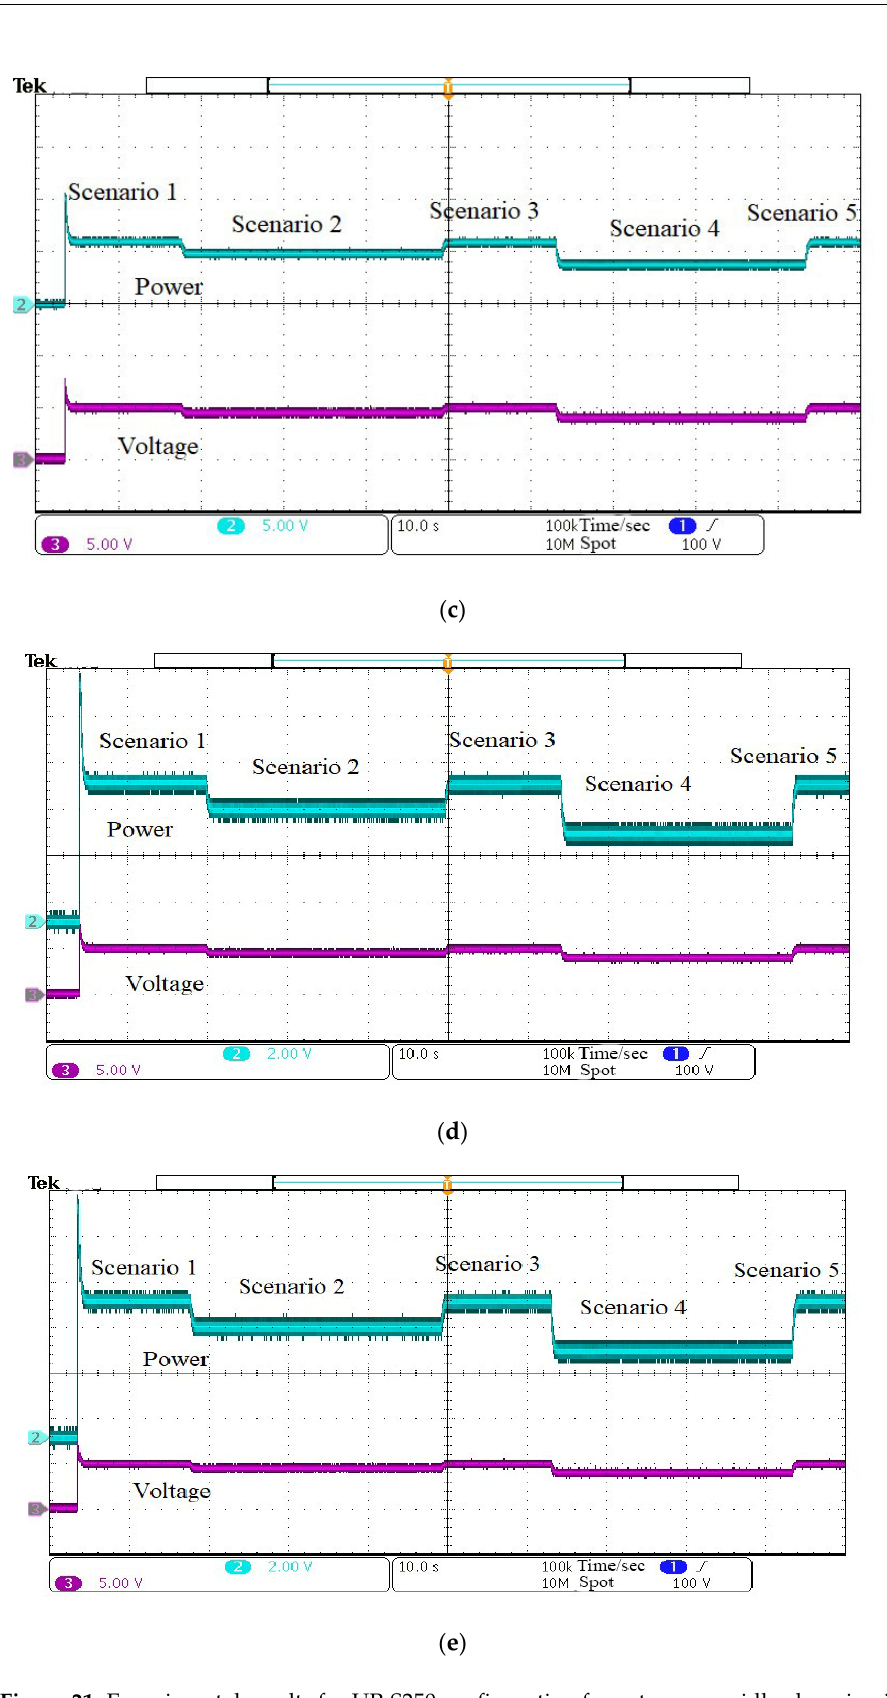
Figure 21. Experimental results for UP-S250 configuration for extreme, rapidly changing insolation scenarios: ( a ) Hybrid CSA-PID; ( b ) CSA; ( c ) MPSO; ( d ) PSO; ( e ) MP&O.